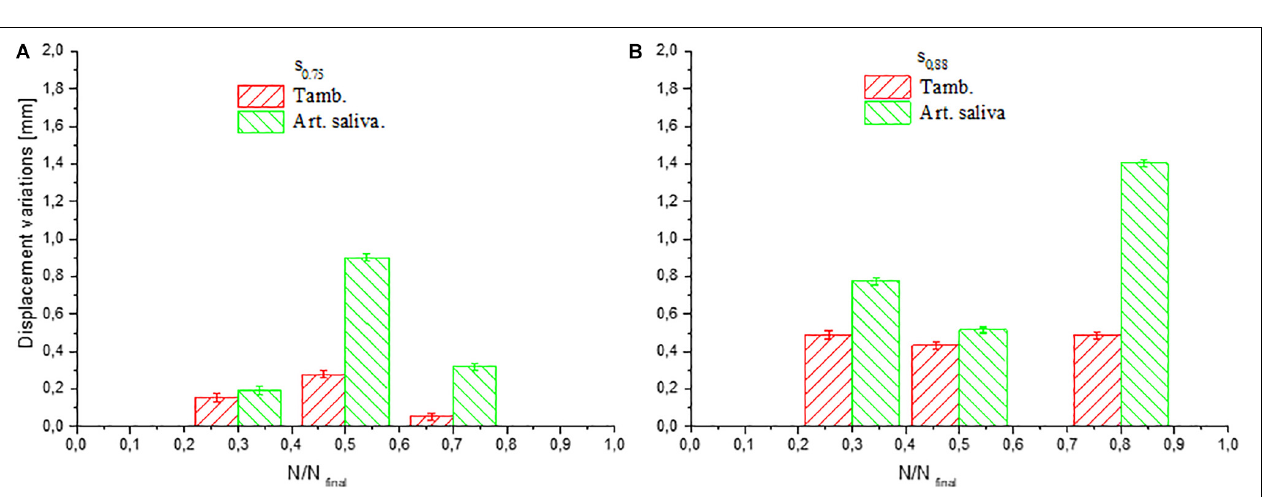
FIGURE 7 | Relationship between maximum displacement and number of cycles of two sample: (A) 0.75 mm sample tested in atmospheric environment ( ∼ 25 ◦ C), (B) 0.75 sample tested in presence of artificial saliva and at room temperature, (C) 0.88 mm sample tested in atmospheric environment ( ∼ 25 ◦ C), and (D) 0.88 mm sample tested in presence of artificial saliva and at room temperature.